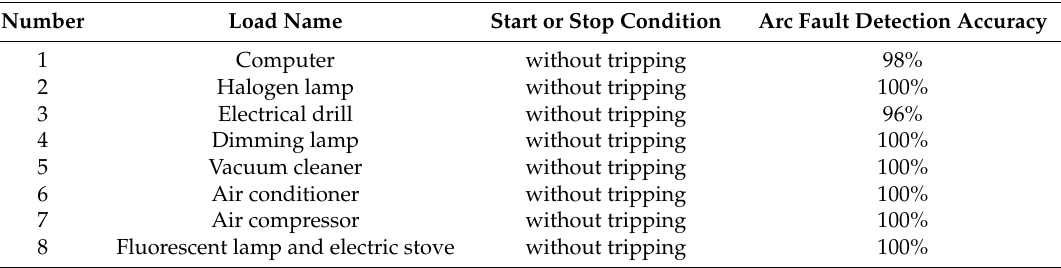
Table 4. Test results under typical